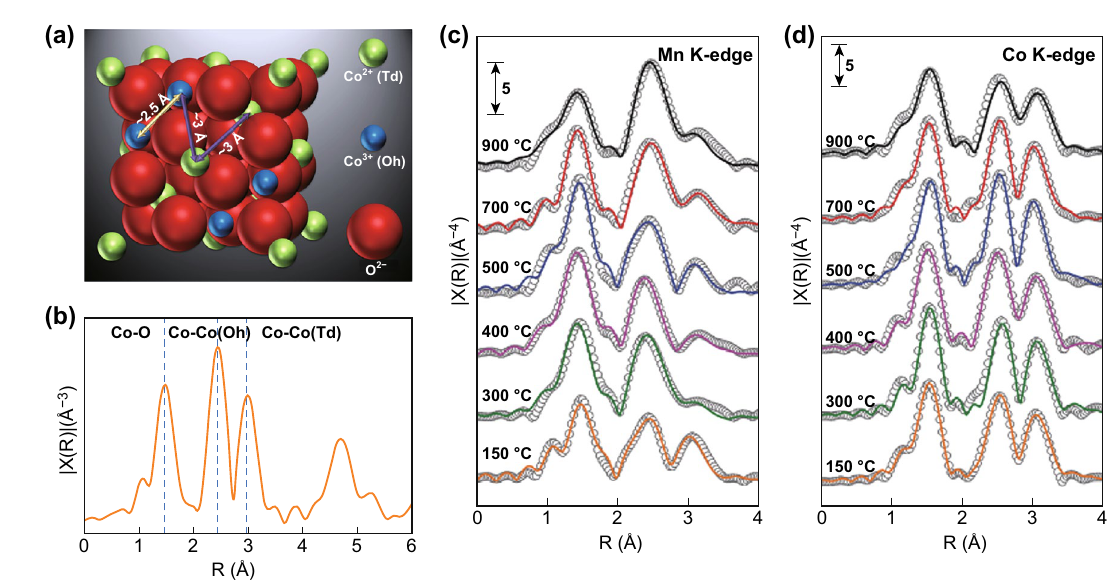
Fig. 5 a The relation of interatomic distance between atom (Oh) and atom (Td) in spinel structure. b Co K-edge EXAFS spectra for Co 3 O 4 , the interatomic distances are shorter than the actual values owing to the fact that Fourier transform (FT) spectra were not phase-corrected. Reprinted with permission from Ref. [63]. EXAFS k 3 χ (R) spectra (gray circles) and fitting results (solid lines) of MnCo 2 O 4 at c Mn and d Co K-edge. Reprinted with permission from Ref.